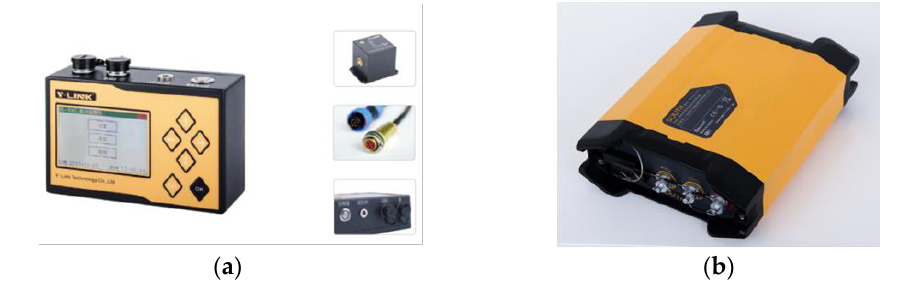
Figure 27. Testing devices: ( a ) Vibration monitor; ( b ) Slope deformation monitor.